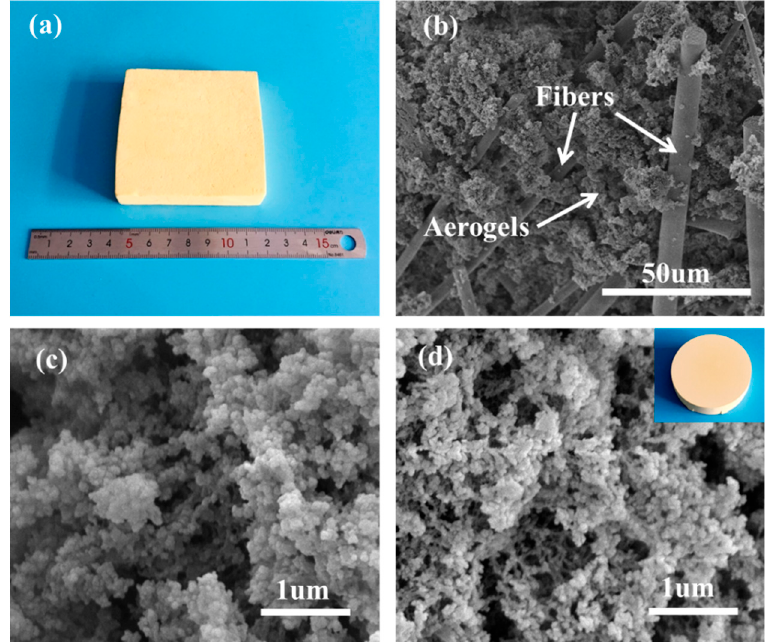
Figure 3. ( a ) photograph of composites, ( b ) SEM image of composites, ( c ) SEM image of PBO aerogel matrix in composites, ( d ) photograph and SEM image of pure PBO aerogel.